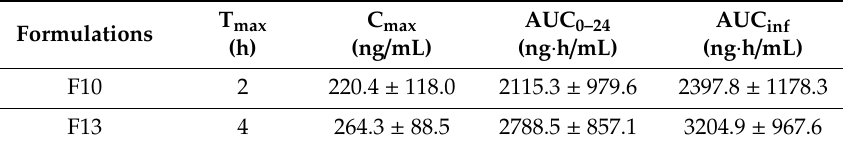
Table 4. In vivo pharmacokinetic parameters for the plasma GS-441524 concentrations of F10 and F13 following a single inhalation administration.